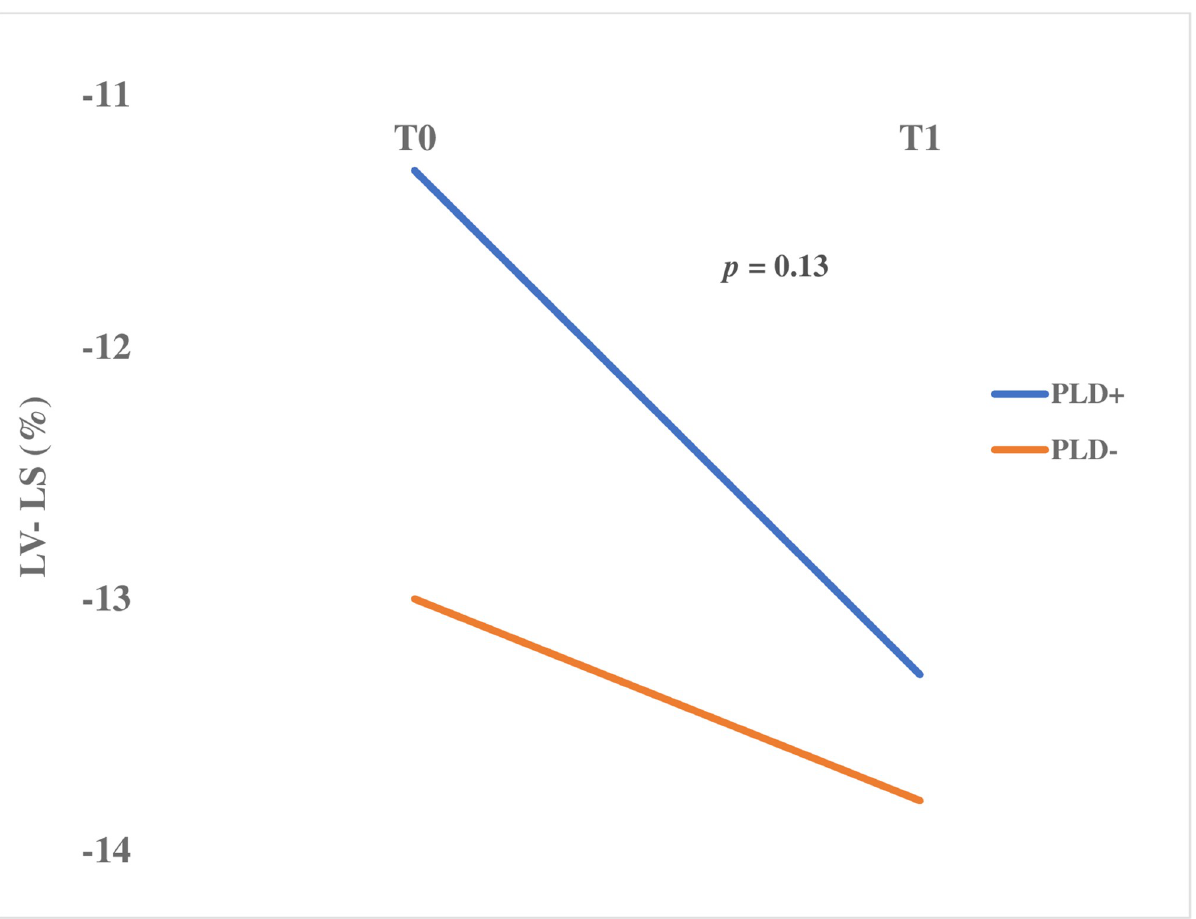
Fig 4. Compared LV-LS variations in-between baseline and PLR, in PLD+ patients versus PLD- patients, using a linear model for repeated measures, p = 0.13.